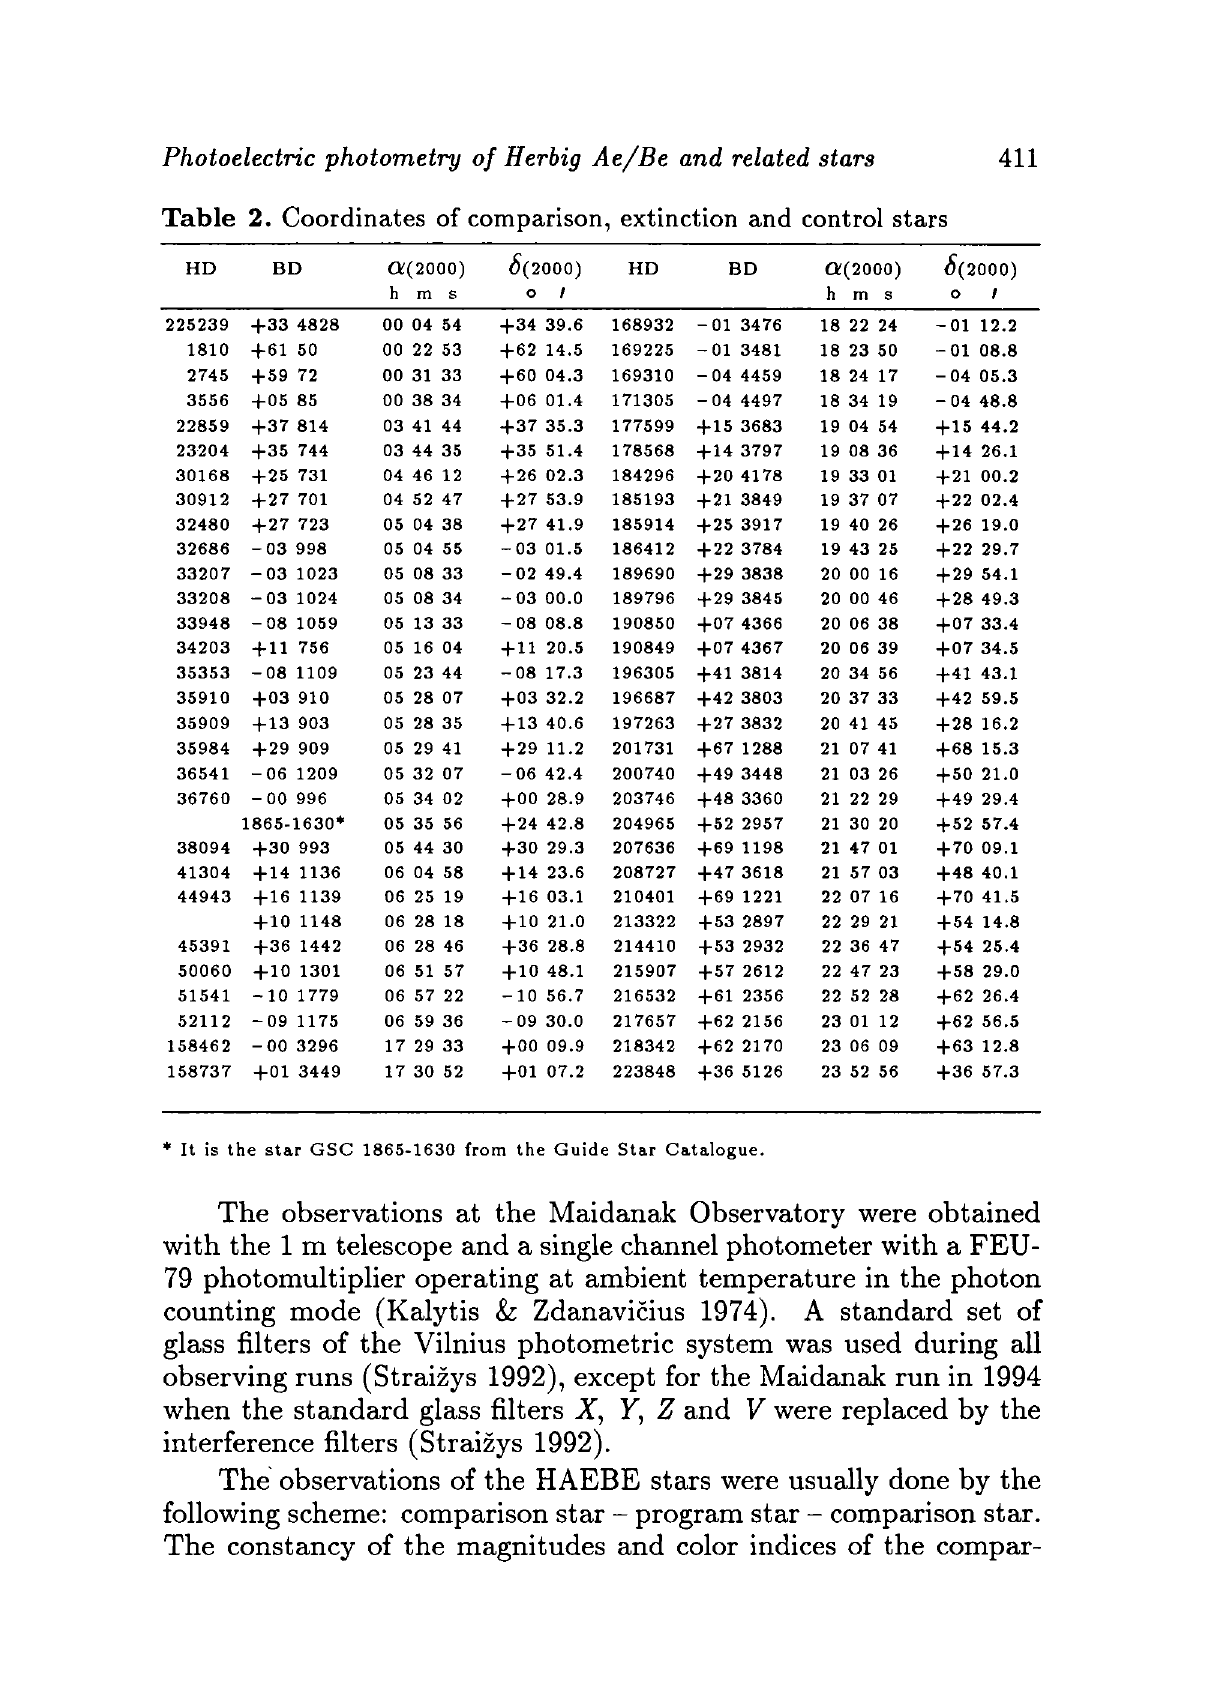
Table 2. Coordinates of comparison, extinction and control